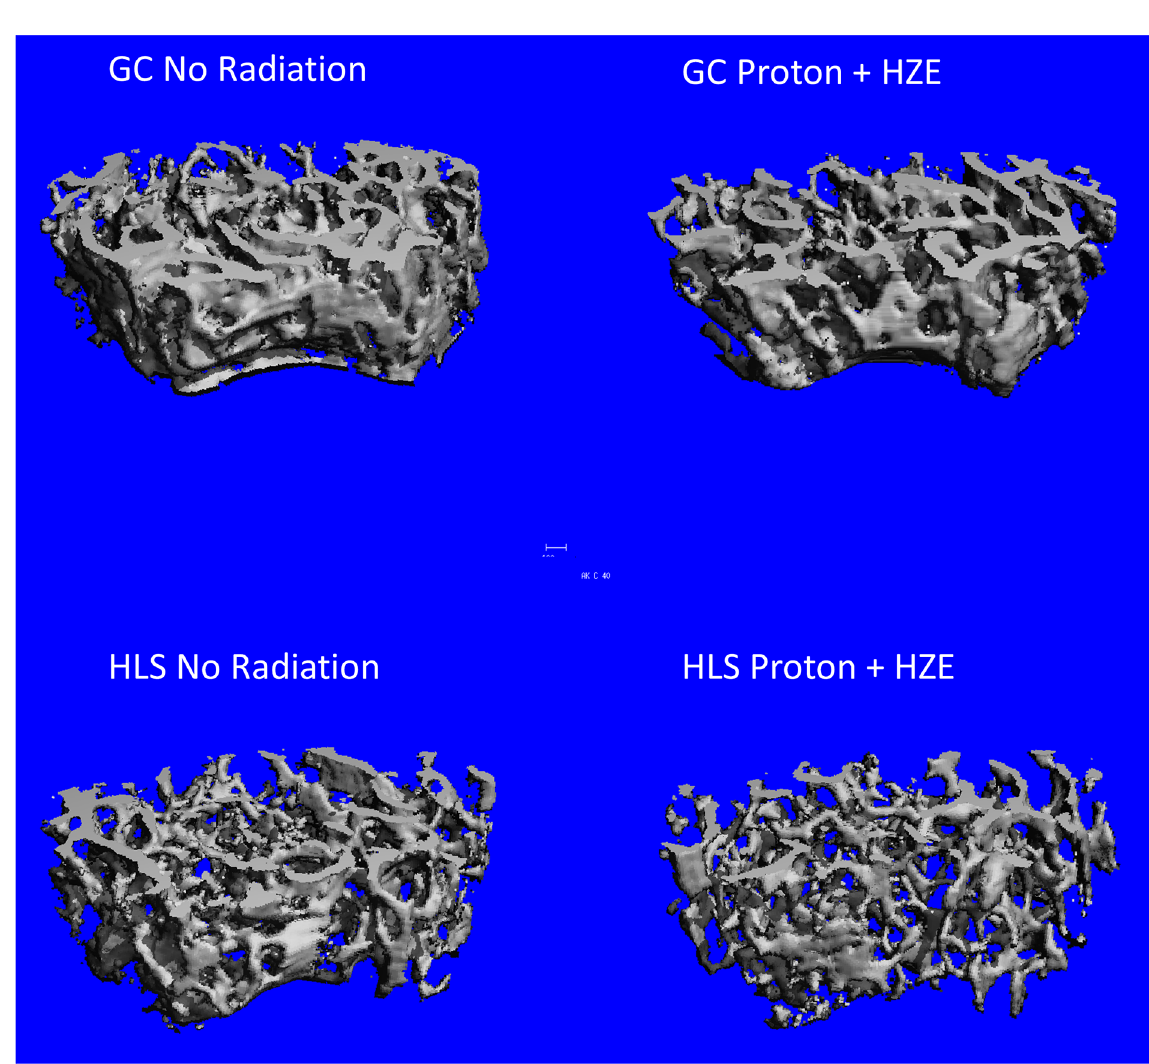
Fig 2. Representative images of trabecular samples from GC mice (top) and HLS mice (bottom) on day 14. Images represent a 72 slice region(756 μ m) of distal femur.